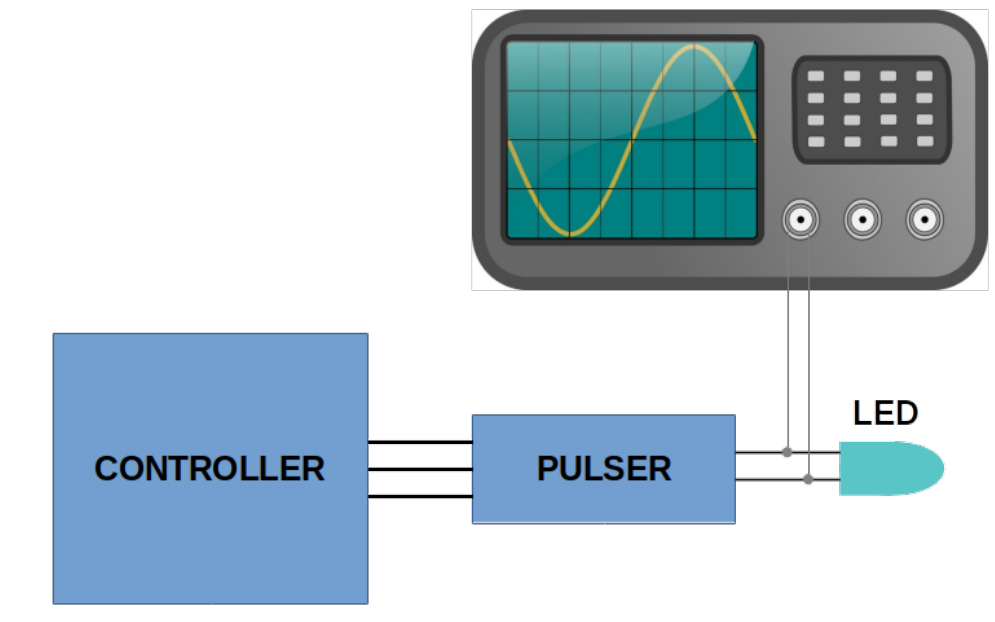
Figure 6. Tests setup for the measurement of the electrical pulse. The electrical pulse is measured by connecting the pads of the LED to one 8-GHz oscilloscope channel.